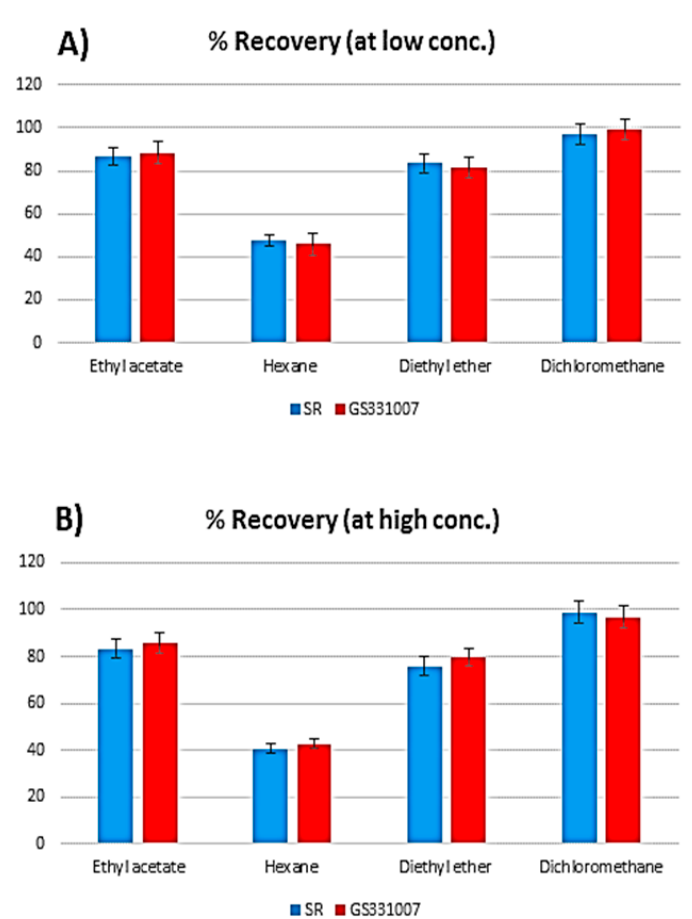
Figure 2. A bar graph showing the extraction solvent effect on the % recoveries of sofosbuvir (SR) and its metabolite GS331007 at low ( A ) and high concentrations ( B ).